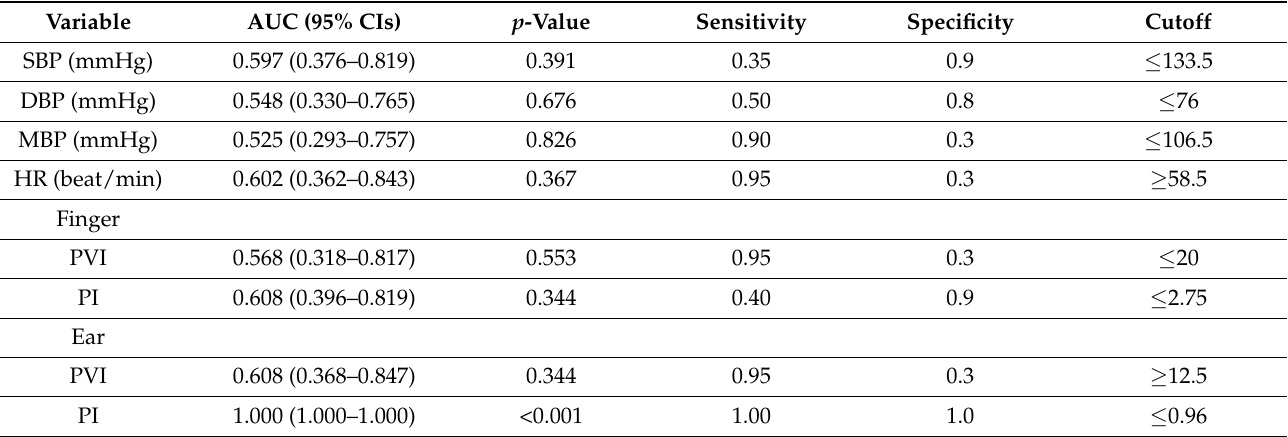
Comparison of AUCs for preoperative hemodynamic variables to predict post- induction hypotension.